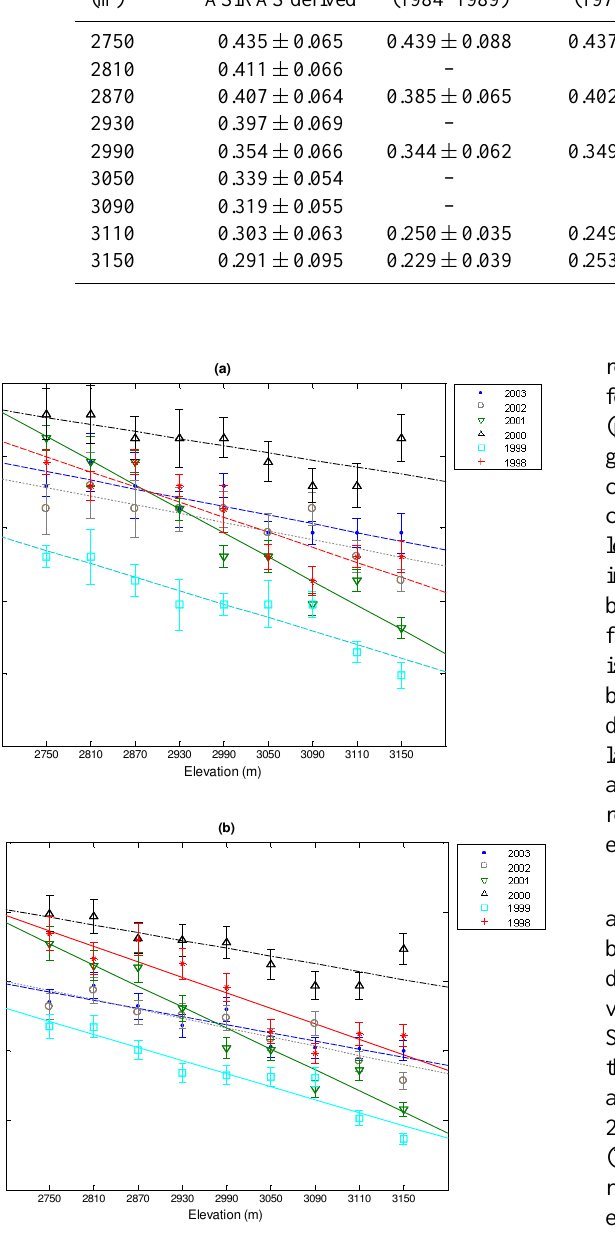
Fig. 3. Six annual layers are identified corresponding to the annual accumulation for each year from 1998 to 2003. Figure 3a show the thickness for each layer. Figure 3b show the annual snow accumula- tion estimates obtained from the different layers identified (m.w.e.). The estimates were made every